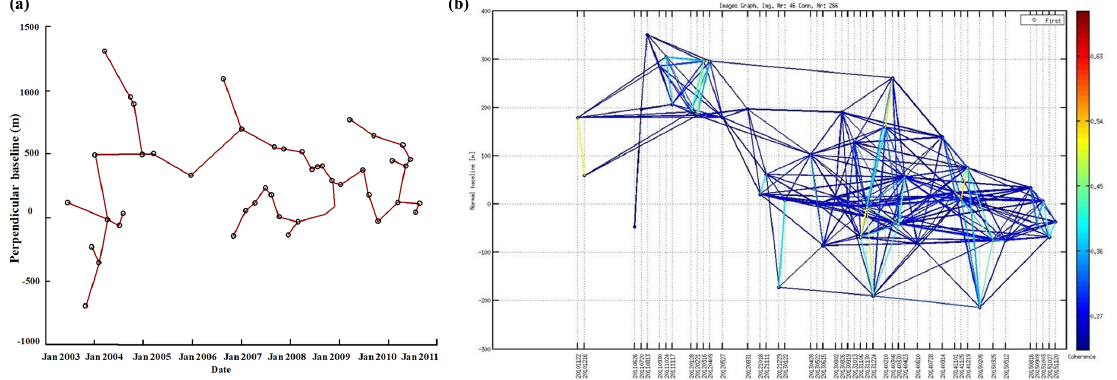
Figure 2. Panel (a) shows the small baseline segment from 2003 to 2010 obtained using SBAS-InSAR. Panel (b) shows the small baseline set from 2010 to 2015 obtained using Quisin-PSInSAR.